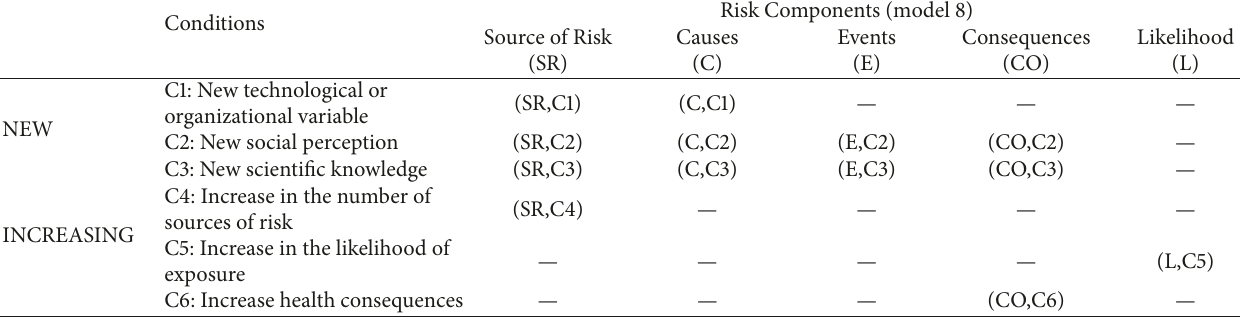
Table 5: Possible combinations between the Ci conditions and the risk components (model (8)) that can form a NER: NR and/or IR (adapted from